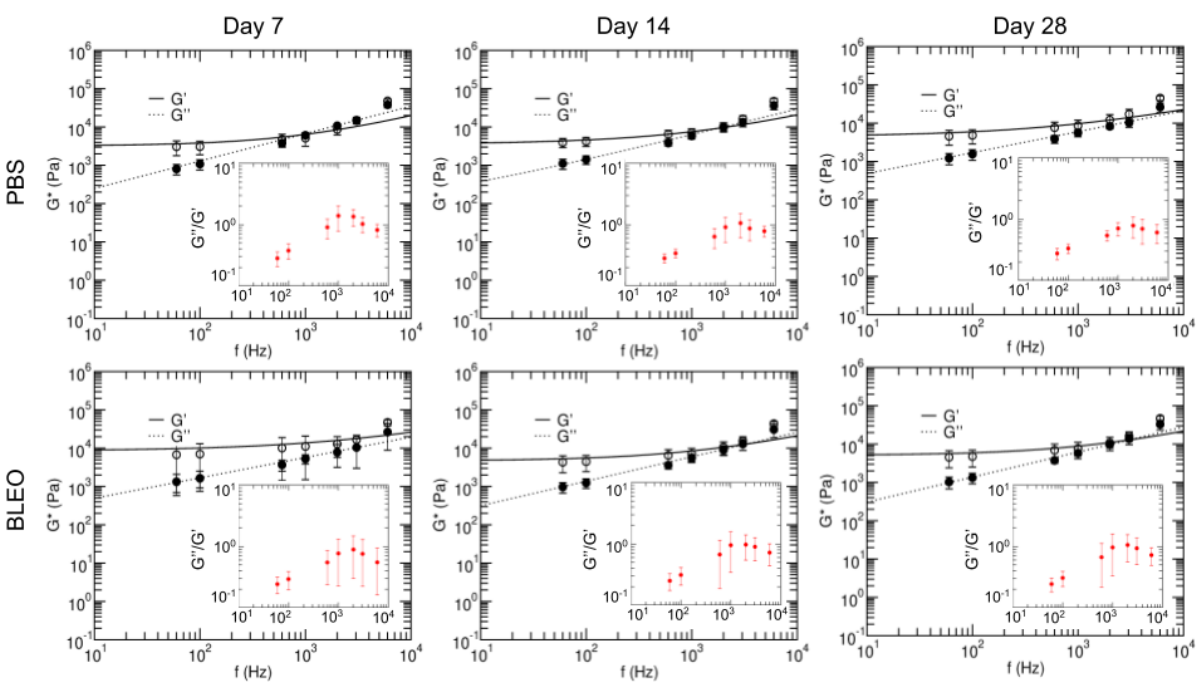
Figure 7. Frequency-dependent complex shear modulus and loss tangents of the lungs at 7 ( left panel ), 14 ( center panel ) and 28 ( right panel ) days after instillation with PBS ( top row ) and bleomycin ( bottom row ). Open symbols represent G (cid:48) and closed symbols, G (cid:48)(cid:48) . Solid and dashed lines are fits of the two-power-law model. Data are mean ± SD. Fit parameters are shown in Table 1. G ∗ ( f ) was modelled using a double power-law (Equation (5)), where a weak power law is observed at low frequencies, followed by a stronger power law at high